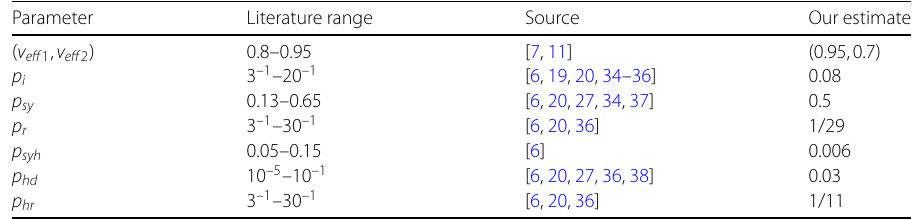
Table 2 Country-independent parameters with literature ranges suggested in the literature. The probability of infection is inverse to the number of incubation days (13 days), the probability of recovering is inverse to the average length of recovery (10 days), probability of leaving the quarantine is inverse to the length of quarantine (14 days). Vaccine efficacy averages around 0.9 Parameter Literature range